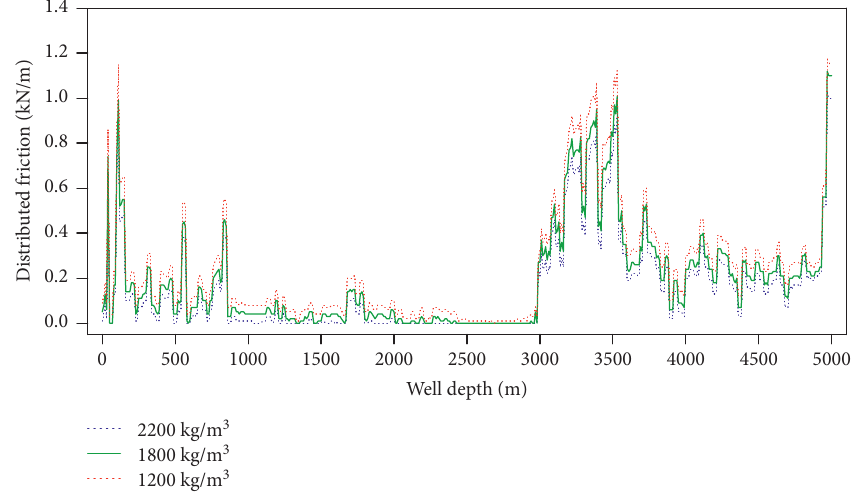
Figure 15: Effect of drilling fluid density on